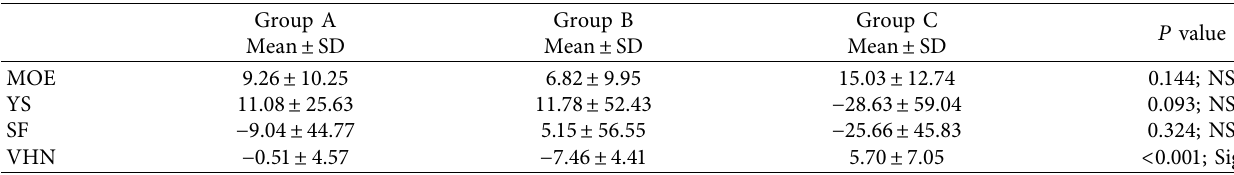
Table 3: Intergroup comparison of the mean percentage reduction in the values of MOE, YS, SF, and VHN was calculated ((base- line − 15weeks)/baseline ∗ 100).